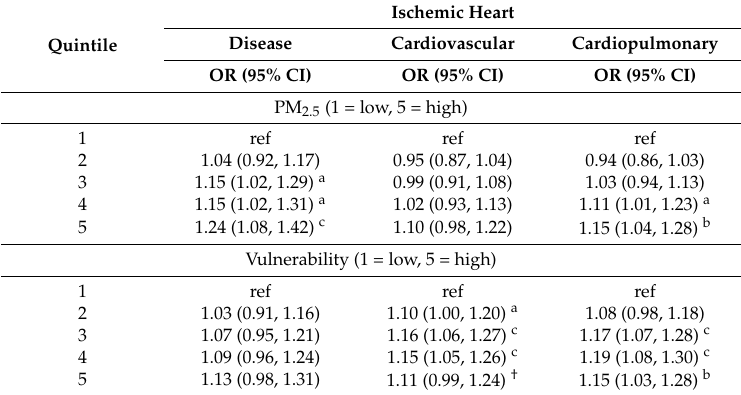
Table 3. Mortality due to ischemic heart disease, cardiovascular disease, and cardiopulmonary disease regressed on PM 2.5 and population vulnerability at the census tract level, adjusted for individual demographic characteristics 1 . Ischemic Heart Disease Cardiovascular Cardiopulmonary Quintile OR (95% CI) OR (95% CI) OR (95% CI) PM 2.5 (1 = low, 5 = high) ref ref ref